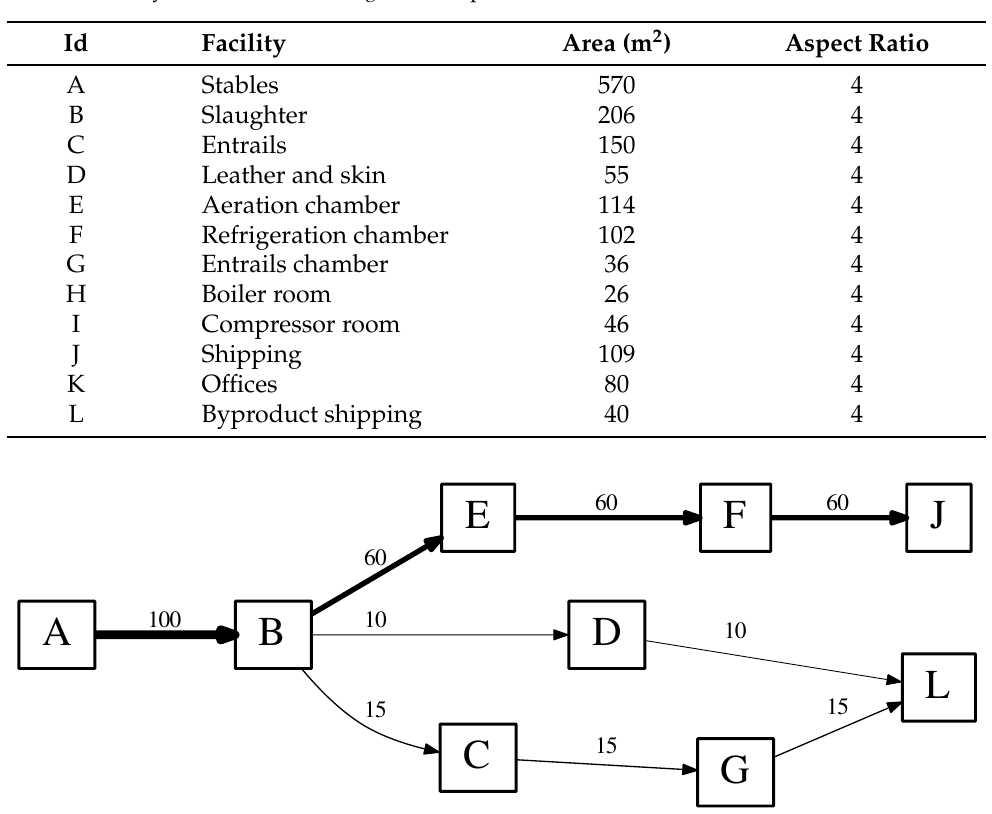
Table 2. Facility features for the Slaughterhouse problem.